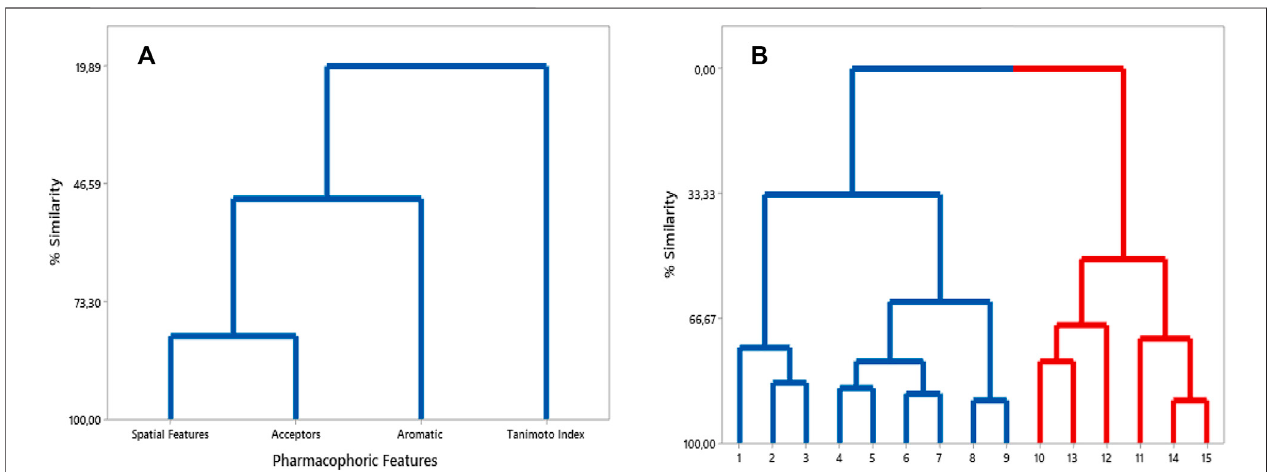
FIGURE 7 | (A) HCA dendrogram built considering pharmacophoric features and TI values. (B) HCA dendrogram for compounds of training set - more similar in blue cluster and less similar in red